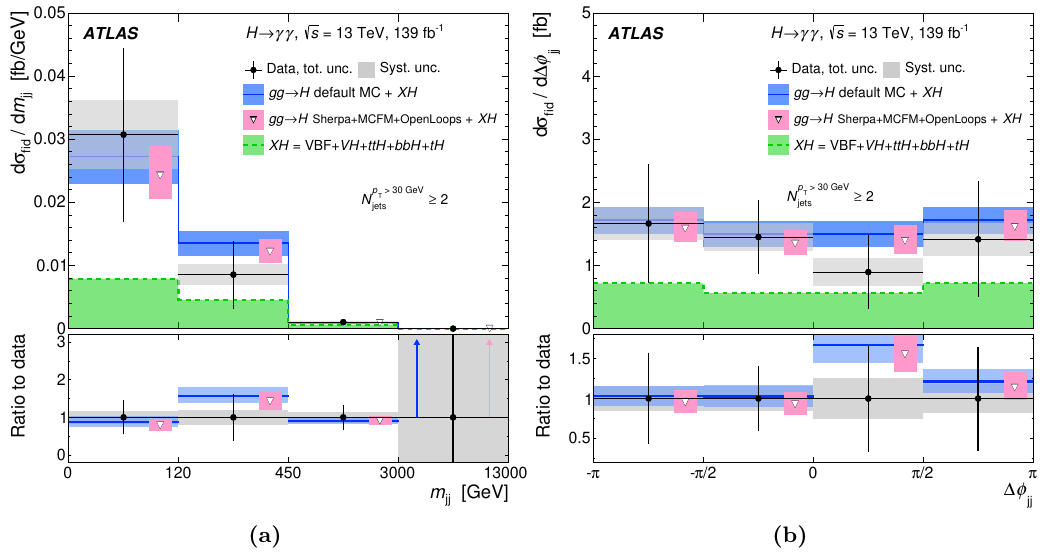
Figure 13. Particle-level fiducial differential cross-sections times branching ratio for the variables (a) m and (b) ∆ φ in the diphoton baseline fiducial region. jj jj